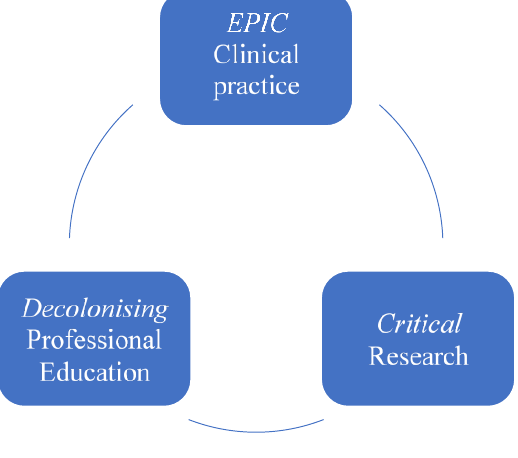
Figure 1: Innovation tools for social justice. Curriculum of practice framework – adapted from Pillay et al.